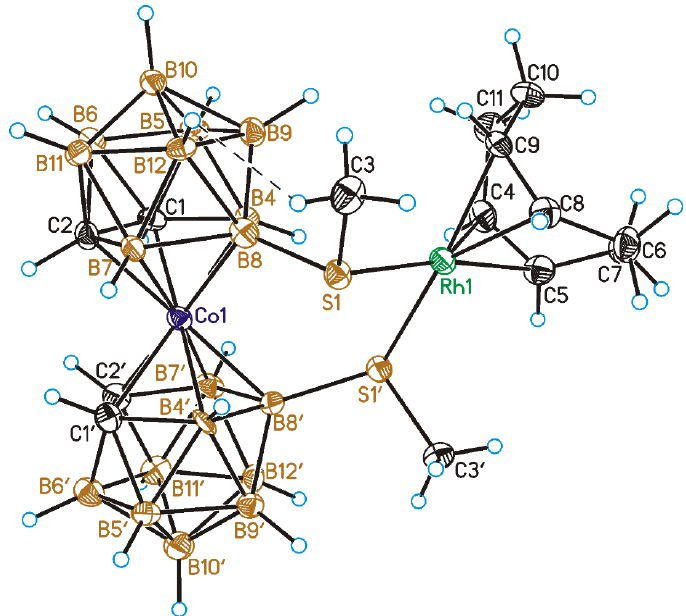
Figure 2. General view of complex 6 showing atomic numbering. Thermal ellipsoids are drawn at 50% probability level. Noncovalent C3-H3A…H12-B12 contact is shown by dashed line. The similar paramagnetic complex {(COD)Rh[8,8′-(MeS) 2 -3,3′-Fe(1,2-C 2 B 9 H 10 ) 2 -κ 2 -S,S’]} ( 8 ) was synthesized starting from the 8,8′-bis(methylsulfanyl) derivative of iron bis(dicarbollide) Cs[ 7 ] and [(COD) 2 Rh](BF 4 ) (Scheme 5).